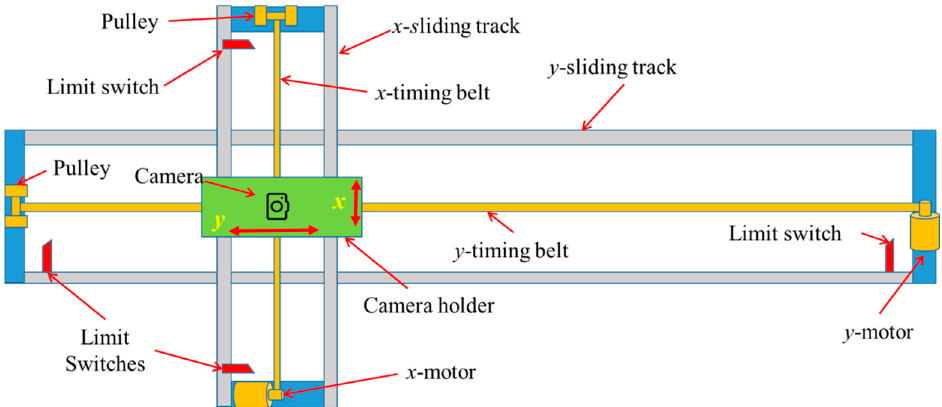
Figure 1. Illustration of the developed image-based platform.